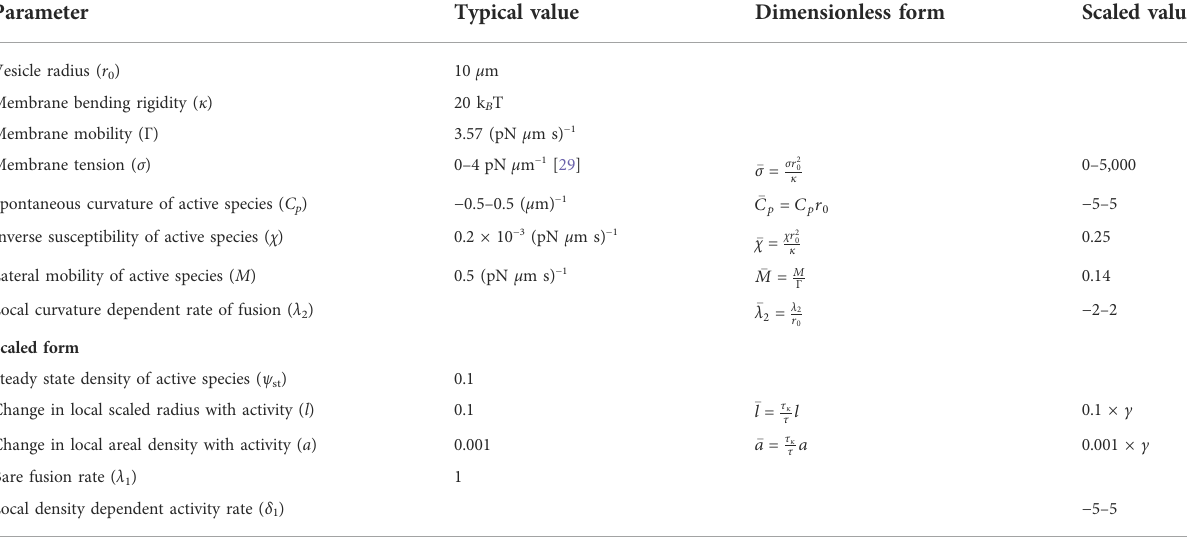
TABLE 1 Parameters considered in the model, their dimensionless form, and the (range of) scaled values used for the stability